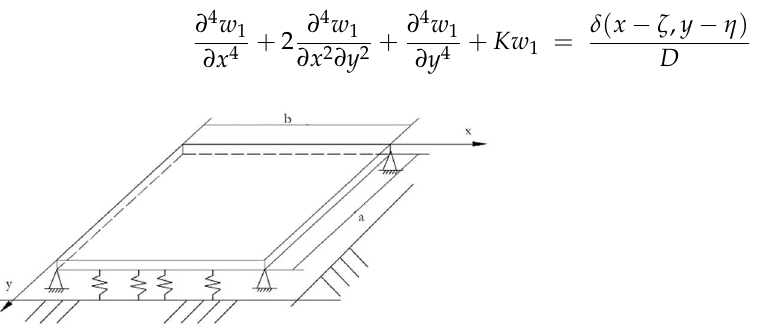
Figure 3. Four-sided simply supported plate.